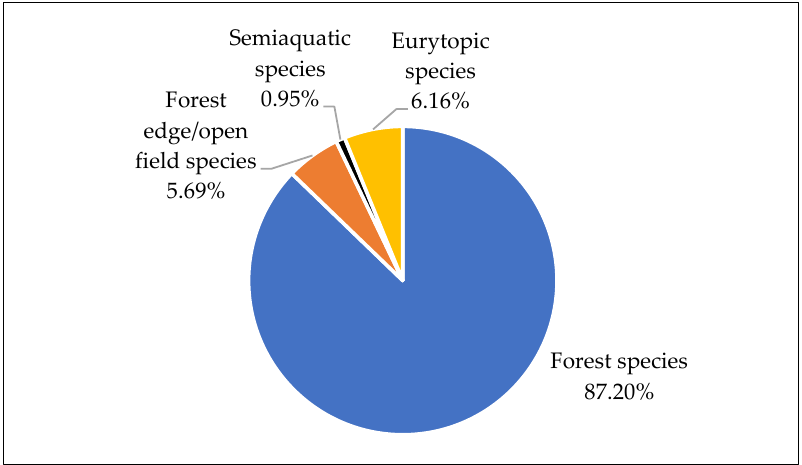
Figure 9. Halmyris, Romania, 2014, extramuros area (4th–6th centuries AD). Proportions of wild mammal species by ecological groups.